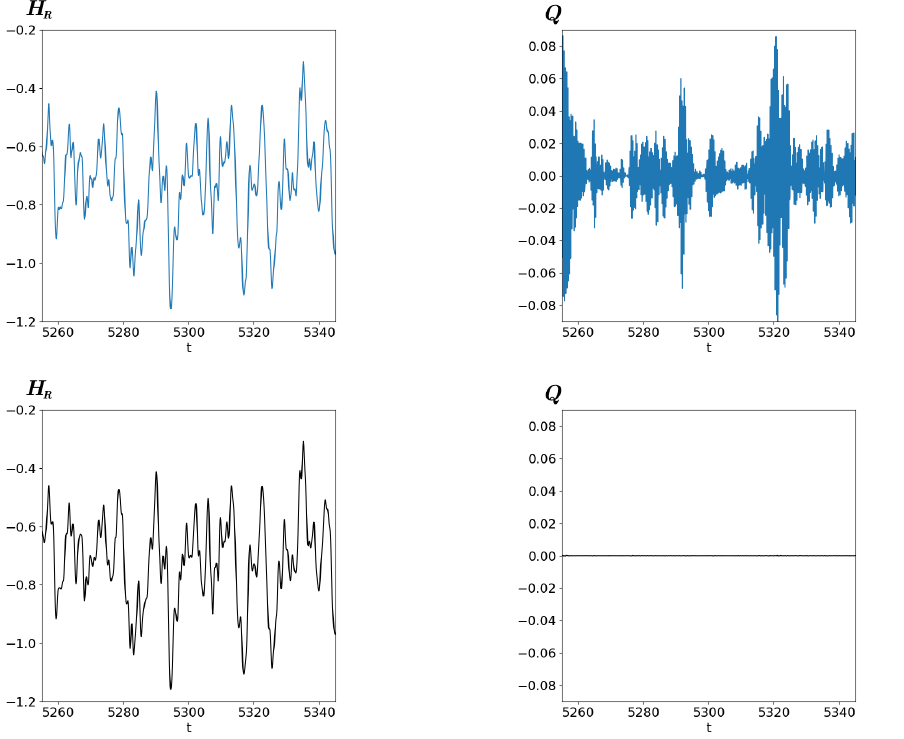
Figure 2: Long-time evolution of the different quantities considered. In blue are the plots corresponding to the cat state (protocol I) while in black are the plots for the mixed state (protocol II) . We see no qualitative difference for H fluctuations of Q around the mean are suppressed for the second protocol, as the consequence of the absence of initial quantum coherences. The blue-shaded region in the top-right panel is the consequence of oscillations occurring on a much shorter time